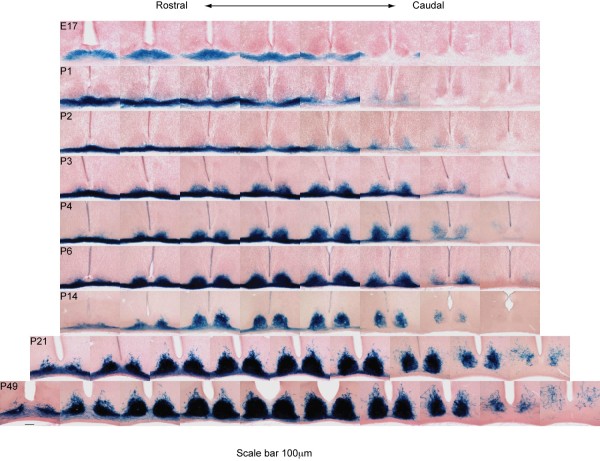
Spatial and temporal progression of SCN innervation. Serial 50-μm coronal sections from individual brains of MelanopsintauLacZ/+ mice at different time points reveal the spatial and temporal progression of ipRGC innervation of the SCN. Nuclei are counterstained with Vector Nuclear Fast Red. Scale bar: 100 μm.